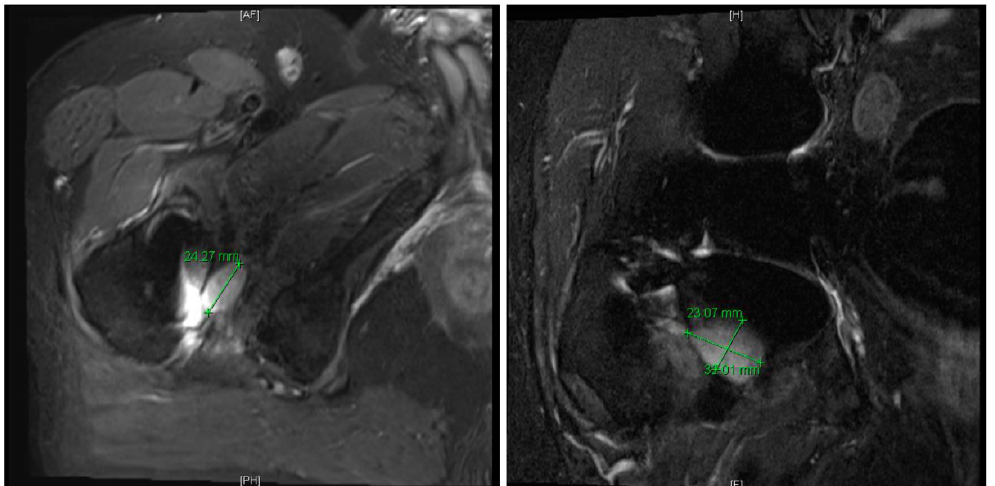
Figure 2. MRI right hip with findings of